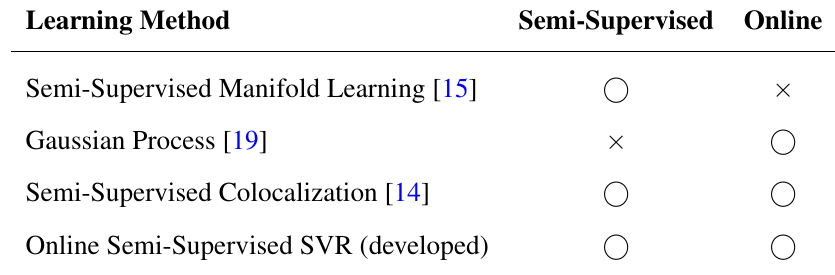
Table 1. Comparative algorithms. SVR, support vector